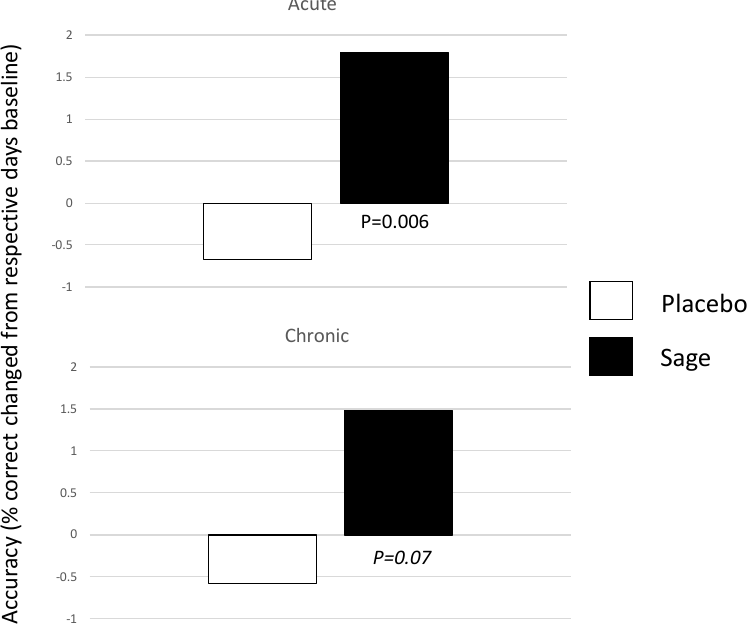
Figure 10. Acute effect of treatment on working memory accuracy on day 1 (top) and day 29 (bottom): the effects of treatment were observed acutely on day 1 ( p = 0.006), and this was trending towards significance for day 29 also ( p = 0.07). In both cases, accuracy was higher (as compared to their own days’ pre-dose performance) in the sage condition as compared to the placebo condition. A pure chronic trend towards significance was observed for “treatment” on day 29, F(1,93) = 3.50, p = 0.07, and a significant interaction between “treatment × repetition” was also seen, F(1,93) = 3.7, p = 0.03. Here, accuracy reduced from baseline in the